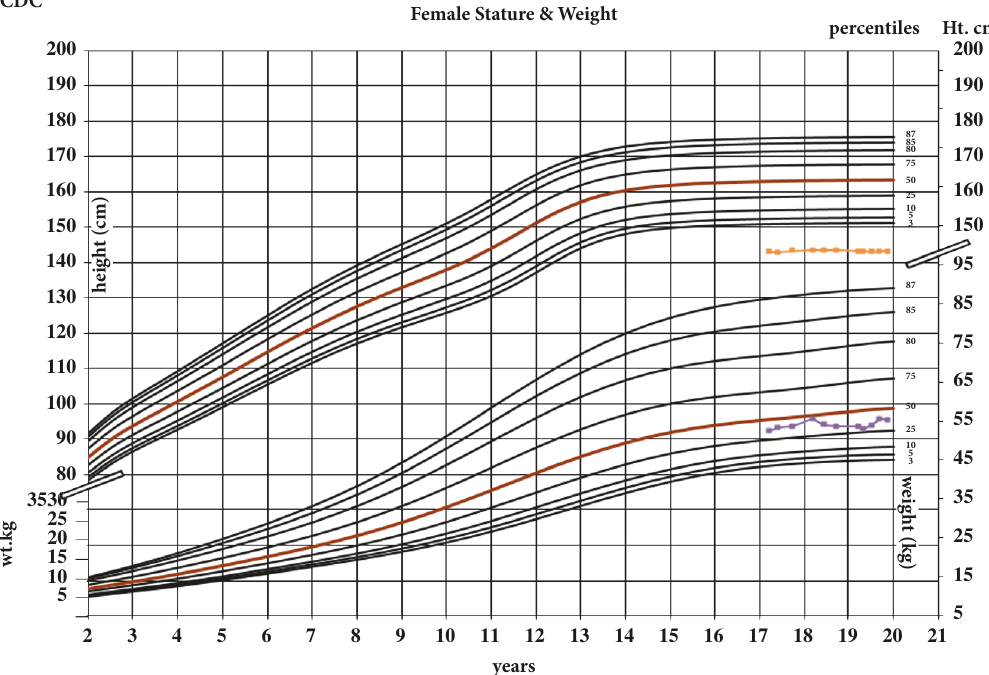
Figure 1: Patient’s weight for age and height for age on CDC growth charts after being 17 years